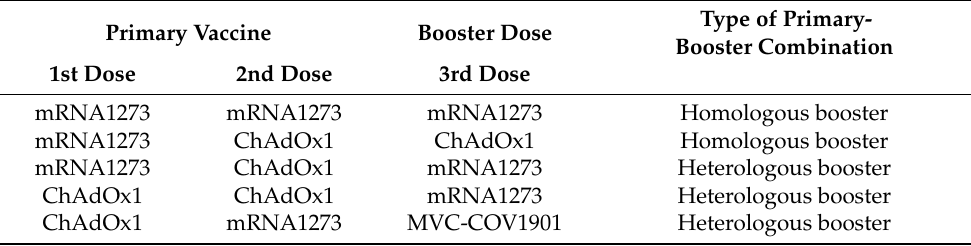
Table 1. Definitions and examples of primary-booster vaccination combinations with mix-and- match